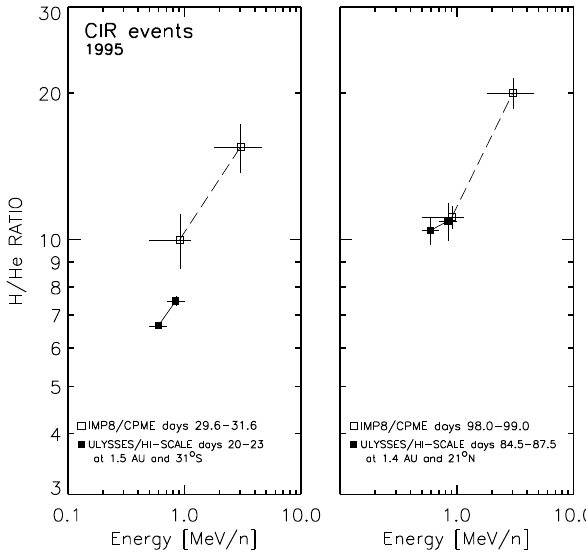
Fig. 4. H/He ratios as a function of energy/nucleon for two different times during two CIR events at Ulysses (solid symbols) and at IMP- 8 (open symbols). The association between the CIR events at both spacecraft was made by Richardson et al.